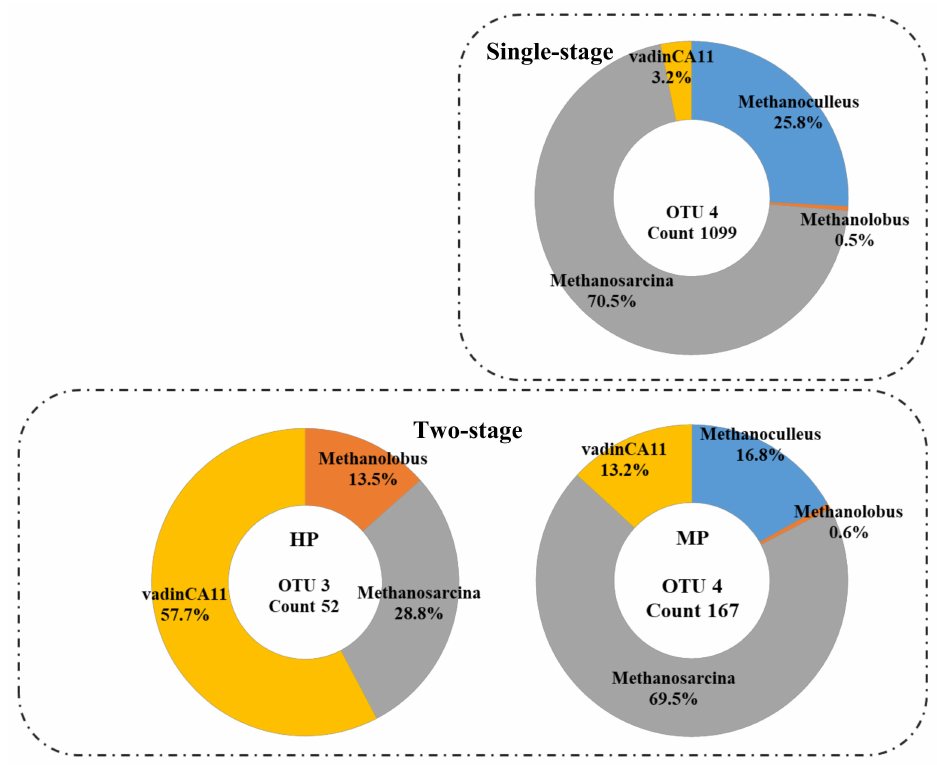
Figure 5. Archaea community at static state period of two-stage and single-stage